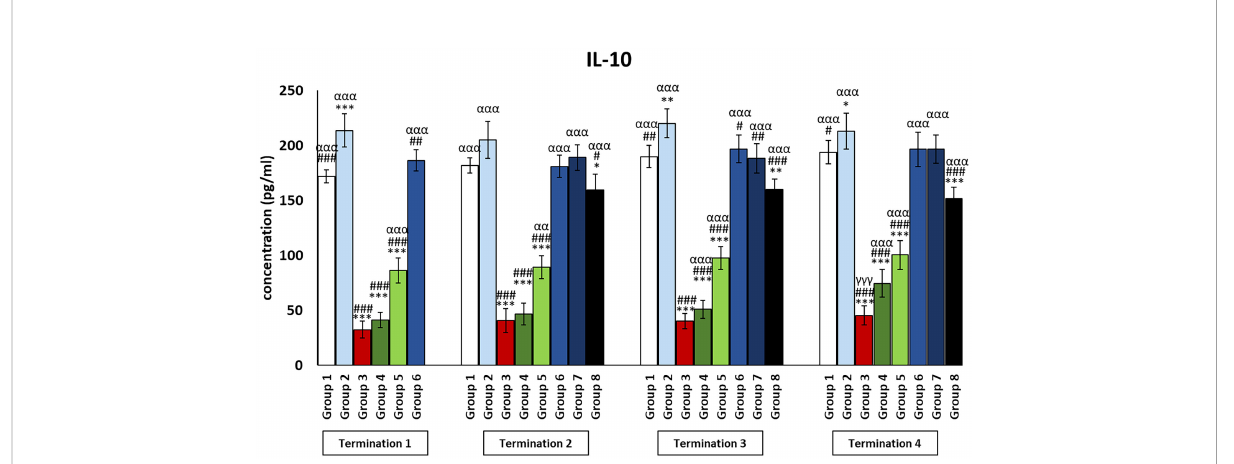
FIGURE 5 Changes in the levels of IL-10 in the blood of chickens receiving phage therapy or antibiotic therapy after 6, 20, 28, and 34 days of experiments. Results are presented as mean values ± SD. Statistical analyses were performed by Kruskal – Wallis test and post-hoc Dunn test or ANOVA and post-hoc Tukey ’ s test. The signi fi cance of differences between controls and particular treated groups is observed and marked by the following: asterisks (*) vs. saline control; (#) vs. phage control (group 2); (a) vs. infected control (group 3); (g) vs. termination 2. p < 0.001 (***, ###, aaa , ggg ), p < 0.01 (**, ##, aa ), and p < 0.05 (*, #).